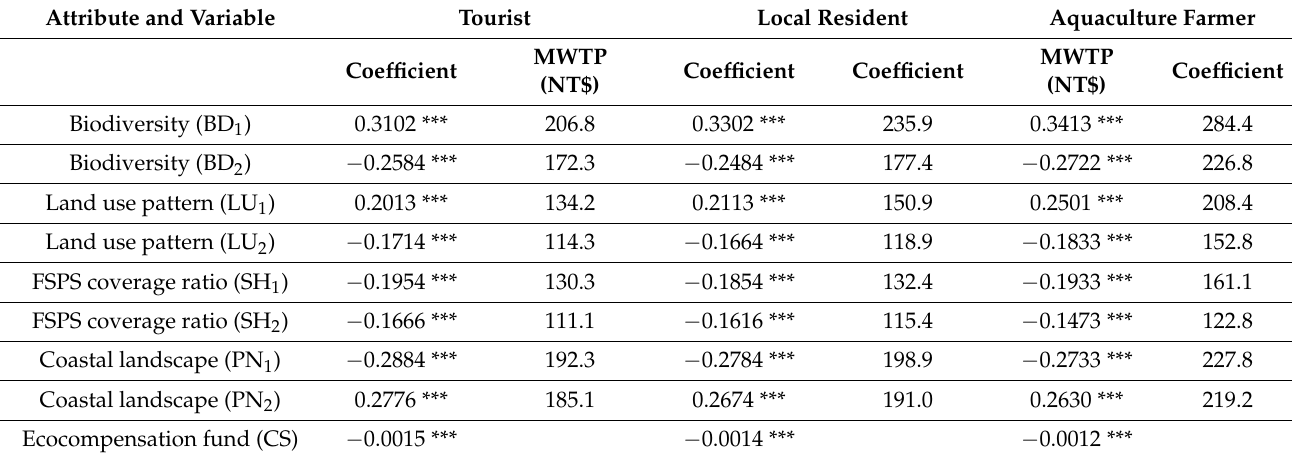
Table 8. MWTP for attributes of the ecosystem conservation preference effect